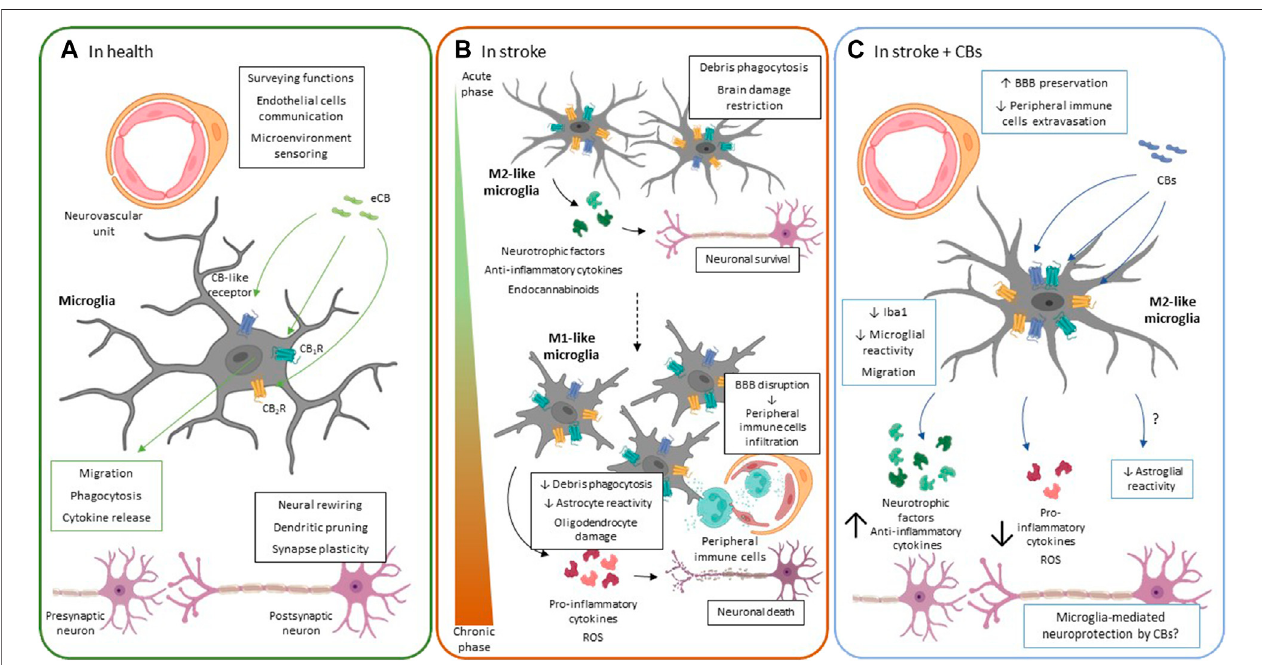
FIGURE 1 | Microglial ECS function. (A). In healthy conditions, microglia participate in pivotal functions for proper neuronal functioning such as dendritic pruning, neural rewiring, secretion of trophic factors and synaptic plasticity. The main function of resting microglia is to monitor the brain parenchyma through their widely branchedmorphologyand toquicklydetectany typeofcellular alteration ordamage.Cannabinoid receptor activationregulatesthephenotypicpolarizationofmicroglia, migration, cytokine production and phagocytic capacity of these cells. (B). Microglial response to ischemic stroke follows a spatio-temporal pattern. Initially, in the acutephase, thereisasigni fi cantincrease inthenumber ofM2-likemicroglialcellsintheischemicarea.TheM2-likephenotype isconsidered protectivesinceitacquires phagocytic capacity that allows it to eliminate the dead cells debris. In addition, they release neurotrophic factors and anti-in fl ammatory cytokines in an attempt to limit neuronal damage. However, during the chronic phase of stroke M1-like cells proliferate and are recruited to the injury area. M1 microglia release pro-in fl ammatory cytokinesandROSthatcontributetoexacerbateneuronaldeath,oligodendrocytedamageandastrocyteactivation.Thein fl ammatoryresponsealsocontributestoBBB rupture and the release of chemoattractant factors from peripheral immune cells. The M1 phenotype is characterized by the acquisition of an amoeboid morphology, without branching and losing its phagocytic capacity thus preventing tissue repair. The expression of CB 1 R and CB 2 R as well as other ECS-related receptors has been upregulated in different in vitro and in vivo stroke models. However, its speci fi c role in microglia is still unknown. (C). The protective effects observed after treatment with CBs in different stroke models include modulation of microgliosis. Reduction in the number of microglia cells was not only observed, but also induced polarization towards theM2-like phenotype. The M2-likemicroglia contributes totissuerepair,asithas phagocytic capacity and releases trophicfactors. In addition, itreleases anti- in fl ammatory cytokines limiting brain damage and preserving the BBB, thus decreasing peripheral immune cell extravasation. Green arrows and boxes: eCB-mediated effects; blue arrows and boxes: CB-mediated effects. BBB: brain-blood barrier; CB 1 R: cannabinoid receptor 1: CB 2 R: cannabinoid receptor 2; CBs: cannabinoids; eCBs: endocannabinoids; ROS: reactive oxygen